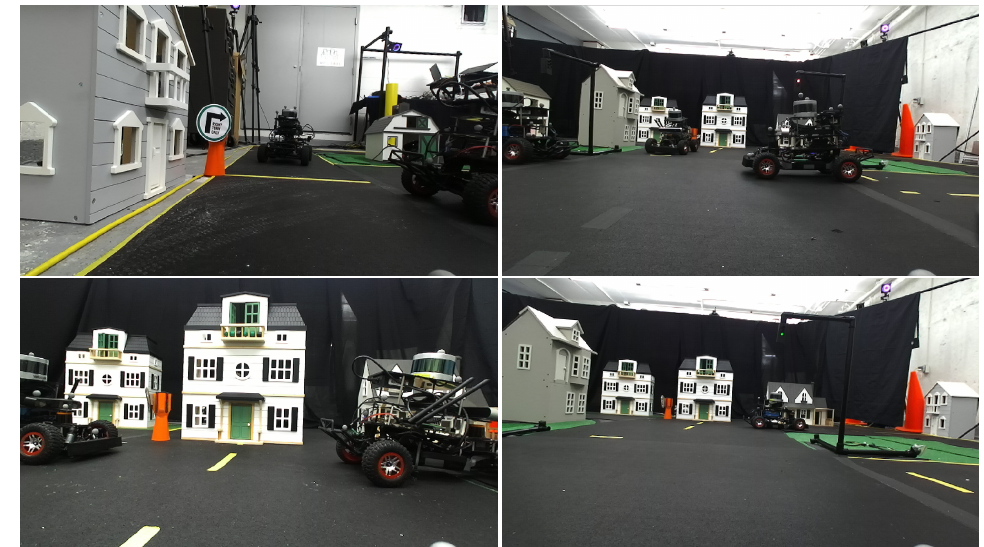
Figure 6. Views from the RACECAR driving in the MiniCity.